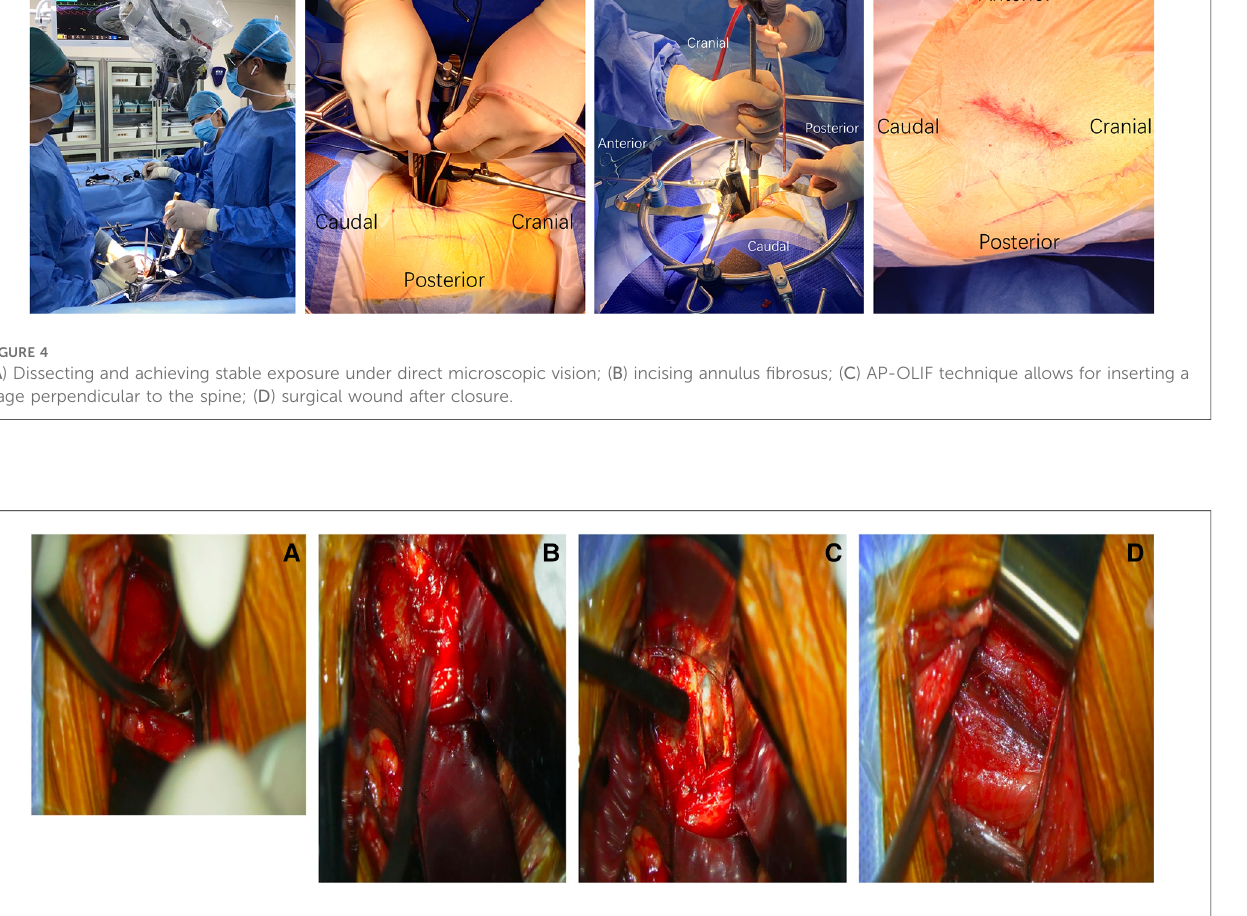
FIGURE 5 ( A ) Intraoperative photograph showing manual psoas dissection under direct microscopic vision; ( B ) intraoperative photograph showing wide and safe access can be achieved with AP-OLIF approach; ( C ) discectomy under microscopic vision. ( D ) Intact psoas after manipulation.